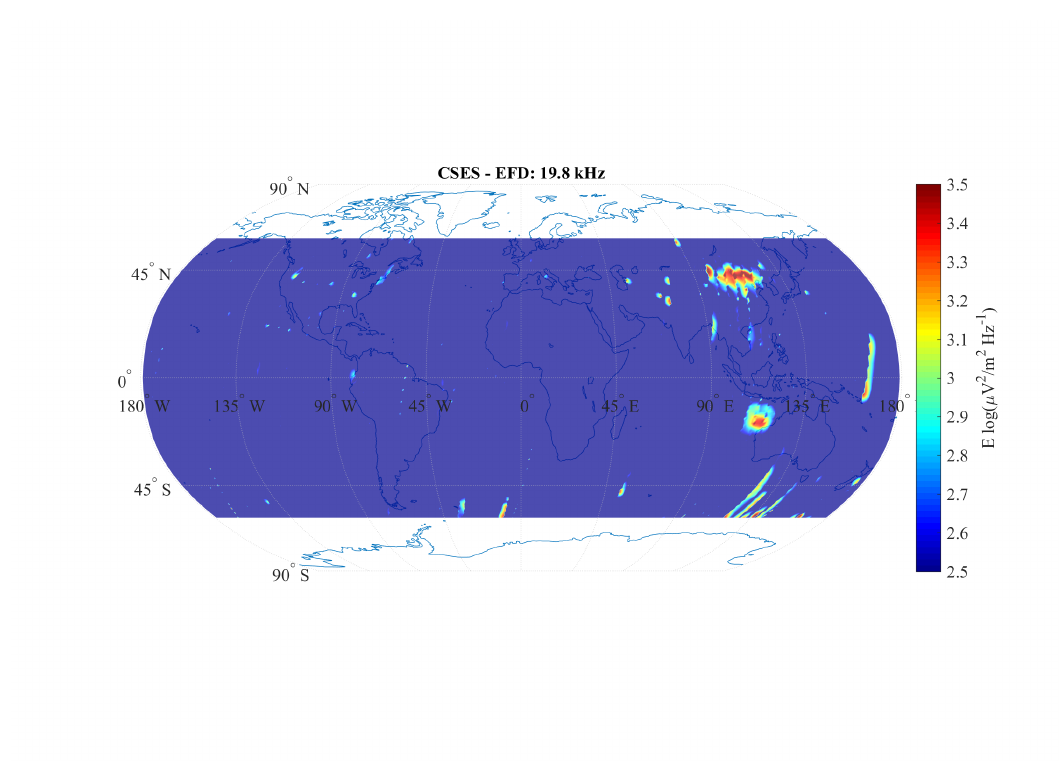
Figure 9. Geographic map showing the intensity of the total electric field recorded at 19.8 kHz by the EFD detector on board CSES-01, average value of the 2019 data. The intensity is color coded according to the color scale on the